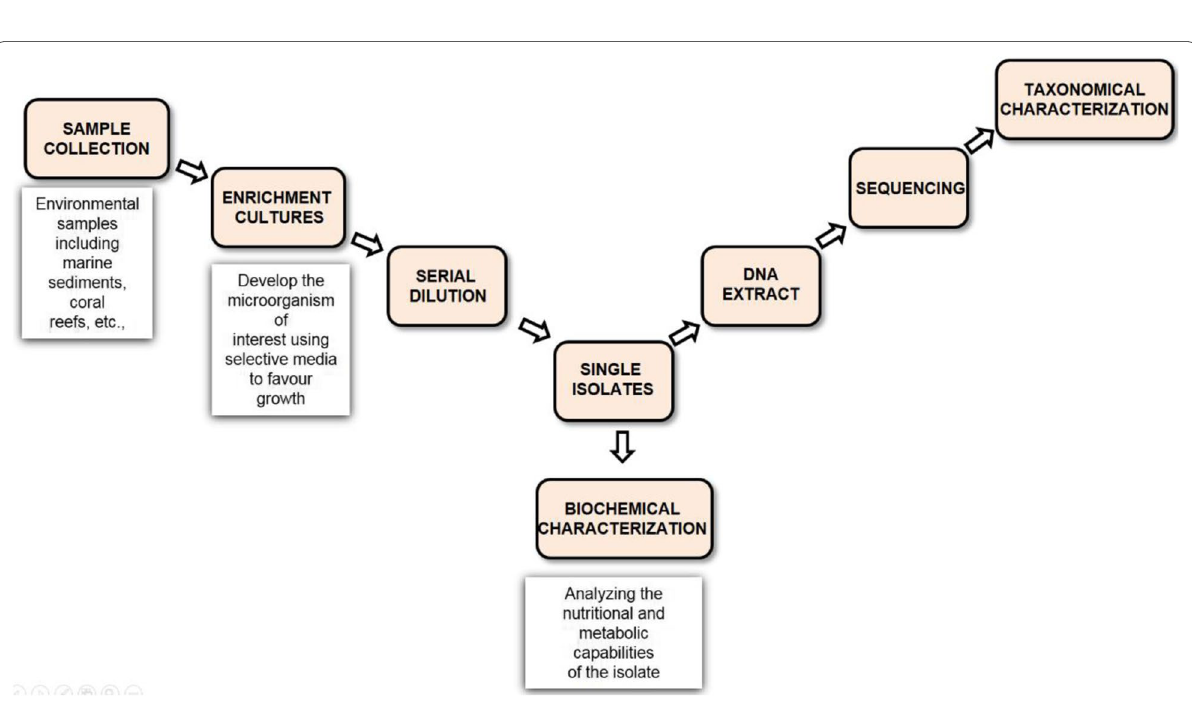
Fig. 2 Sample collection and processing by culture-dependent approach (In the culture-dependent method, the microorganisms are enriched using selective media followed by biochemical characterization and taxonomical